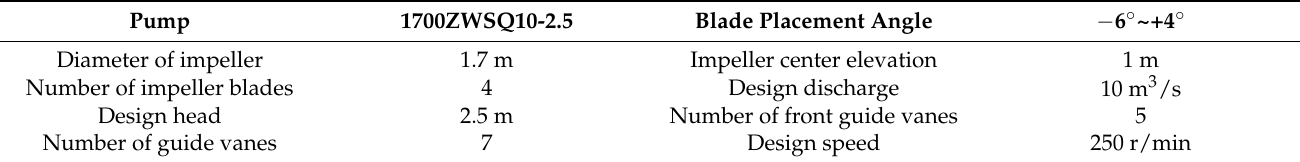
Table 1. Relevant design parameters of the pump.